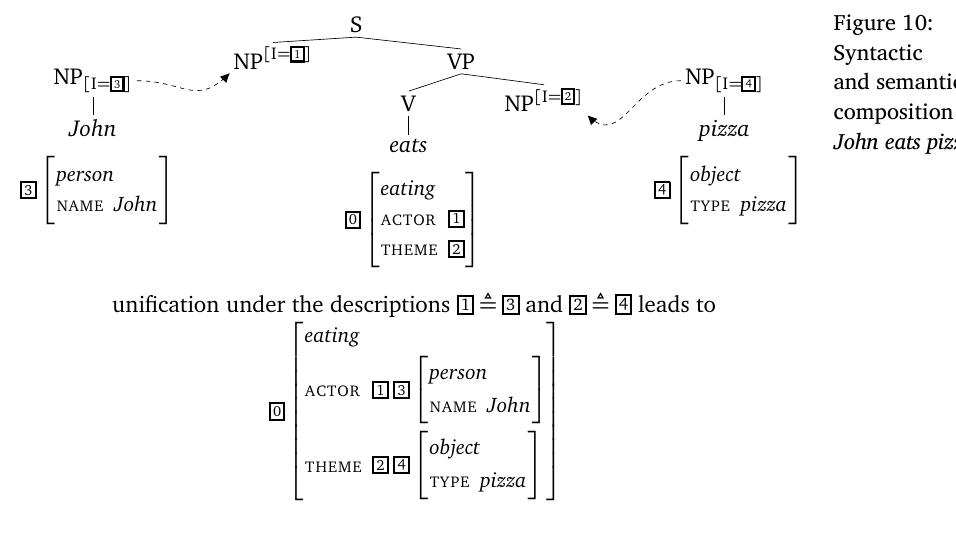
Figure 10: Syntactic and semantic composition for John eats